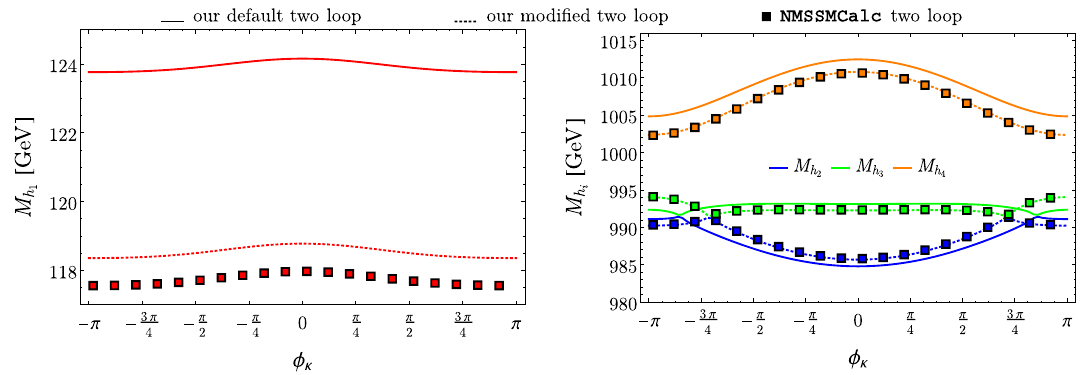
Fig. 7 Mass predictions as a function of φ κ for the lightest, mostly SM-like Higgs state h 1 on the left-hand side, and the states h 2 ( blue ), h 3 ( green ) and h 4 ( orange ) on the right-hand side. The latter involve essentiallythe CP -evensingletandthetwo CP -evenand CP -oddheavy- doubletdegreesoffreedomthatmixsubstantially.The fullcurves corre-